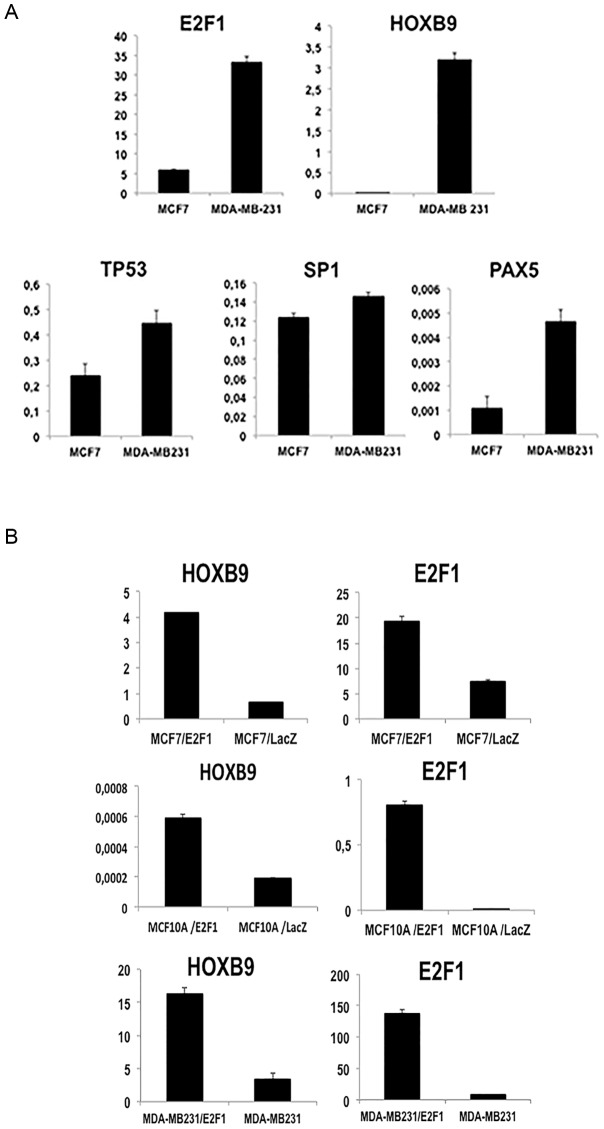
E2F1 as a possible candidate for regulating HOXB9 expression.Bioinformatic analysis of transcription factor binding sites (TFBS) of the HOXB9 region suggested several candidates as transcription factors: E2F1, PAX5, TP53, and SP1. (A) The mRNA expression of such candidates in MCF7 (HOXB9 expression low) and MDA-MB-231 (HOXB9 expression high) indicated the possible binding candidate by Q-PCR analysis. (B) The mRNA level in comparison with GAPDH of HOXB9 and E2F1 in MCF10A, MCF7, and MDA-MB-231 either with or without exogenous E2F1 displayed the positive correlation.